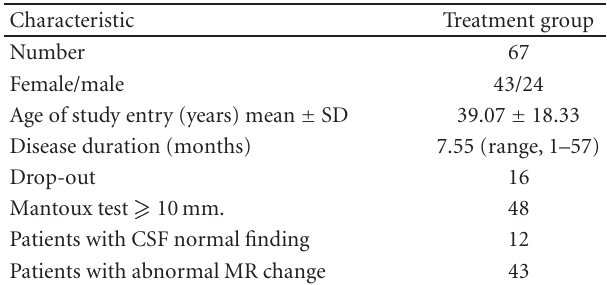
Table 1: Baseline demographic and clinical information at inclu- sion.